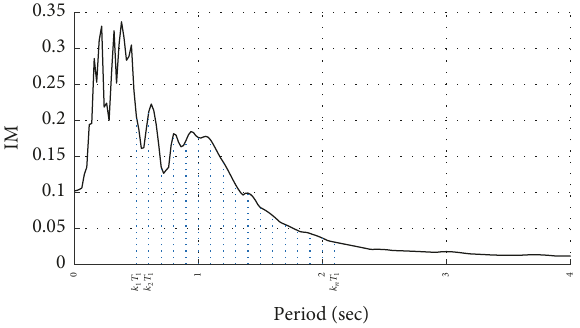
Figure 5: Schematic approach to calculate the average spectral acceleration from the response spectrum of a seismic record.